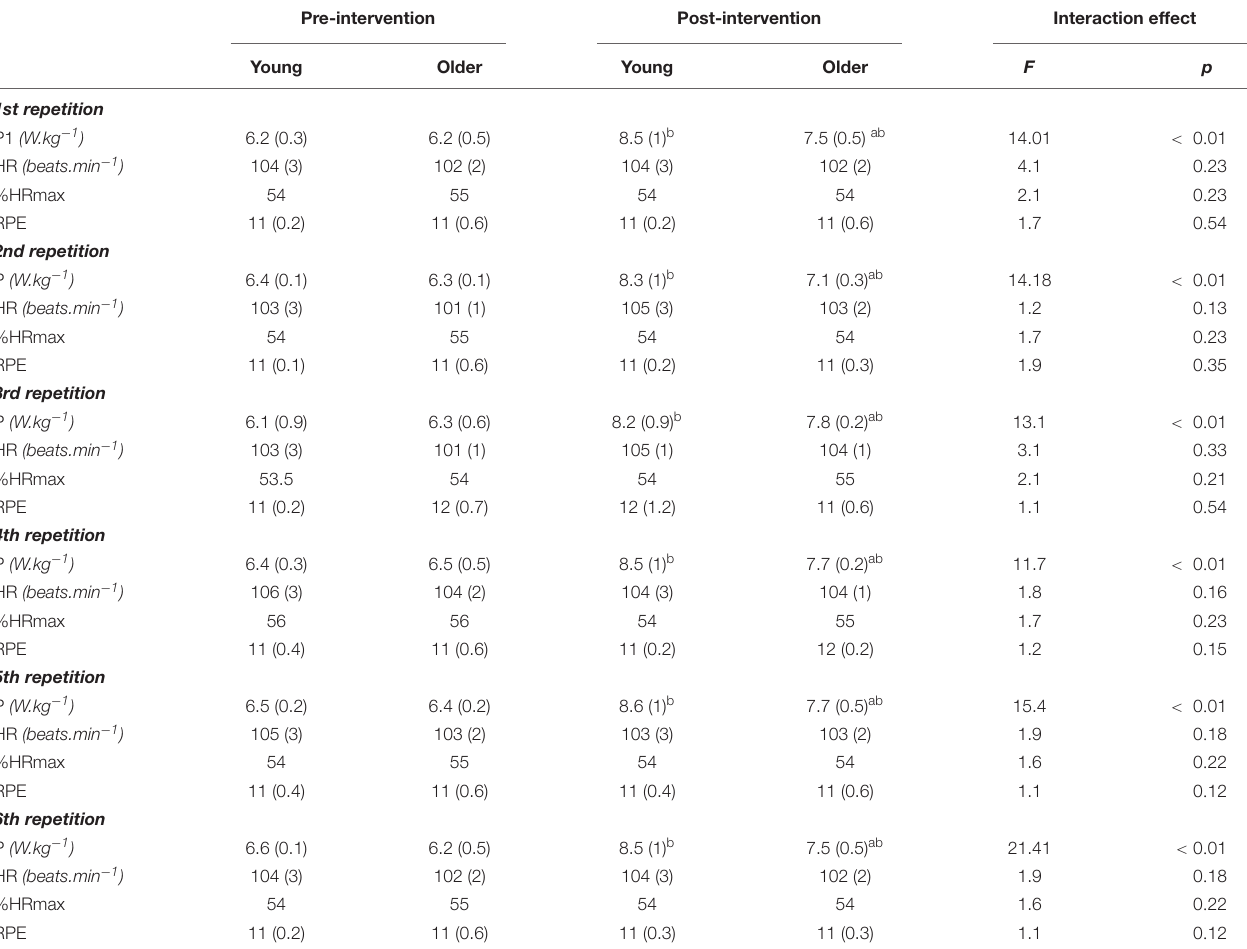
TABLE 4 | Results on measured variables during the 6 repeated supramaximal cycling exercises at the first (pre-intervention) and the last (post-intervention) HIIT session for both young and older groups. Pre-intervention Post-intervention Interaction effect Young Older Young Older